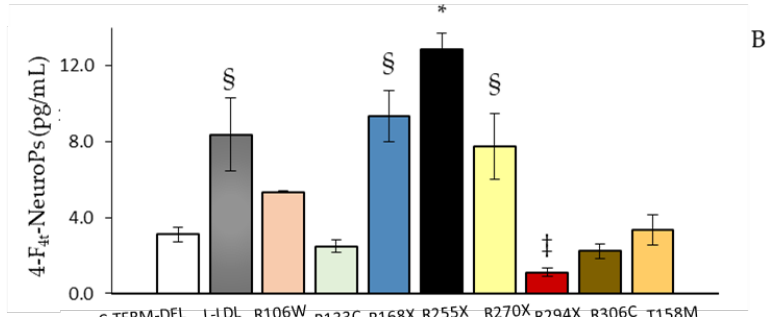
Figure 3. Plasma levels of 10-F 4t -NeuroP ( A ) and 4-F 4t -NeuroP ( B ) in RTT subjects as a function of MECP2 “hotspots” mutation. Data are means (columns) with standard deviations. ANOVA test: p < 0.001 ( A , B ) and Scheffé test for all pairwise comparisons: p < 0.05. Panel A: * different from C-Terminal deletion, R106W, R133C, R294X, R306C, and T158M; ‡ different from C-TERM_DEL, L-DEL, R106W, R168X, R255X, R270X, R294X, T158M; § different from 270X: Panel B: * different from all reported mutations; § different from C-TERM-DEL, R133C, R255X, R294X, R306C, and T158M; ‡ different from all the hotspots mutations, with the exception of R133C and R306C. Legend: C-TERM-DEL, C-terminal deletions; L-DEL, large deletions.